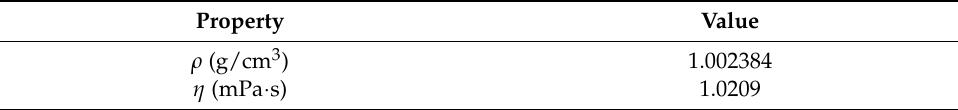
Table 3. Physical properties of the optimized formulation at 298.15 K.